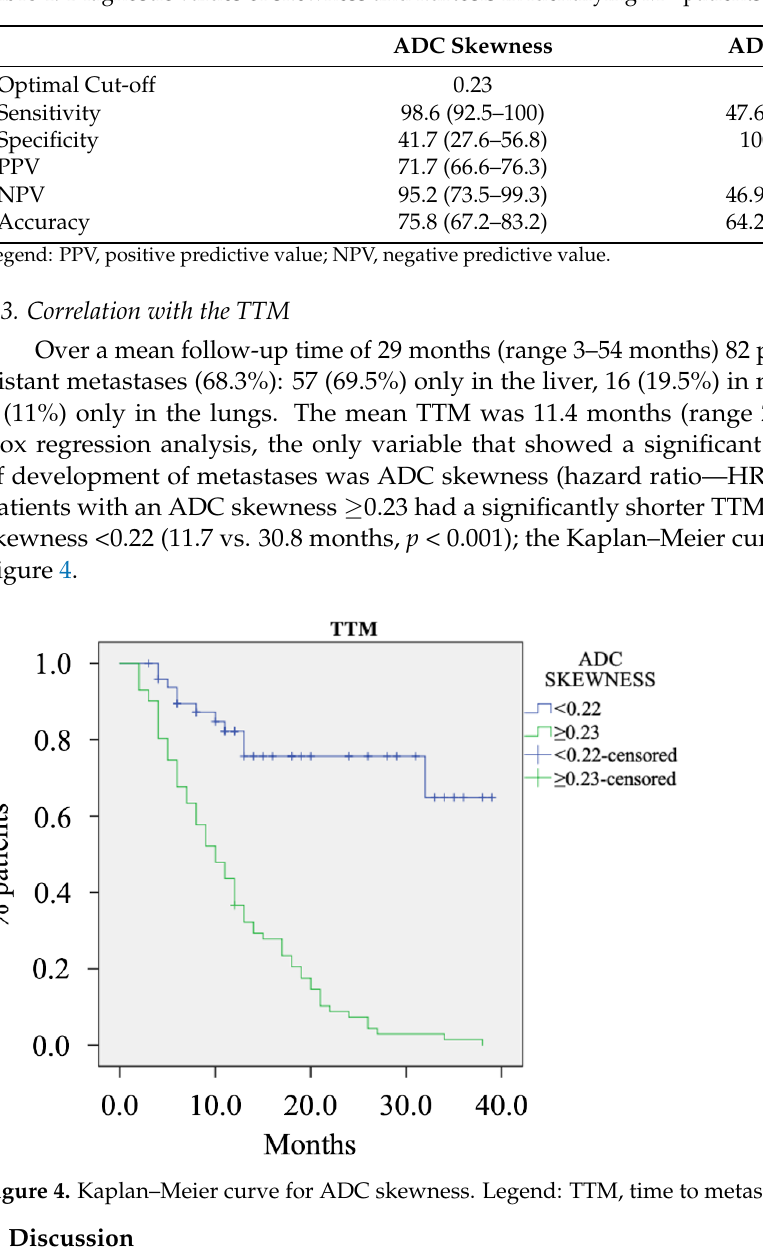
Table 4. Diagnostic values of skewness and kurtosis in identifying M+ patients.